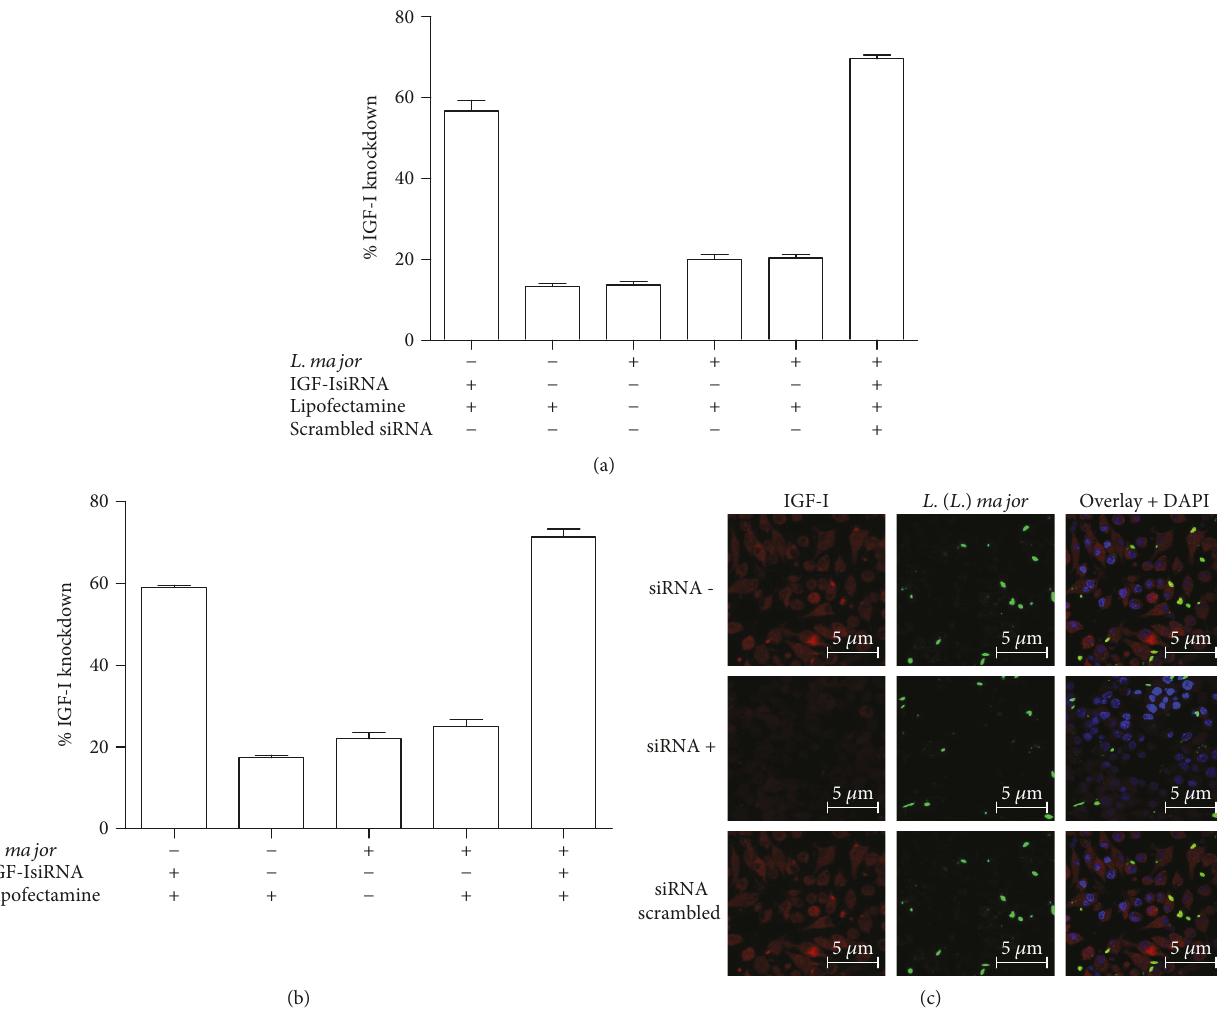
Figure 3: Expression of Igf-I mRNA upon IGF-I silencing with an siRNA. The percentage decrease in the amount of Igf-I mRNA in RAW 264.7 cells (a) or BALB/c peritoneal macrophages (b) infected with L. major promastigotes that were transfected with 150 μ M siRNA, scrambled siRNA, or Lipofectamine alone 6h after infection is shown. One representative experiment from three independent assays is shown. (c) The detection of IGF-I expression in L. major promastigote-infected RAW 264.7 cells transfected with (siRNA+) or without the IGF-I siRNA (siRNA − ) or with a scrambled siRNA using confocal microscopy of immunostaining with a 1:75 dilution of an anti- IGF-I antibody (using an Alexa Fluor 546-conjugated secondary antibody; red) and a 1 :200 dilution of an anti- Leishmania antibody (using an Alexa Fluor 488-conjugated secondary antibody; green) is shown. Nuclei were stained with DAPI (blue). Images were captured using a confocal Leica LSM510 microscope with a 63x oil immersion